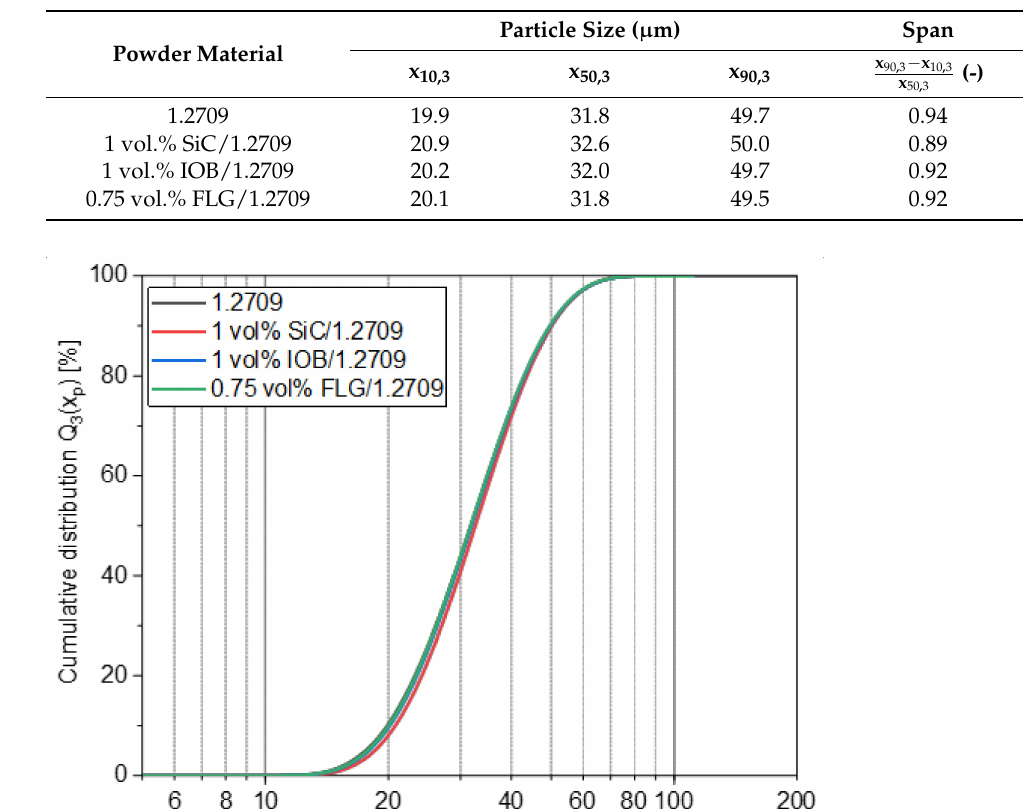
Table 4. Particle size distributions of feedstock powder 1.2709 and coated powders.